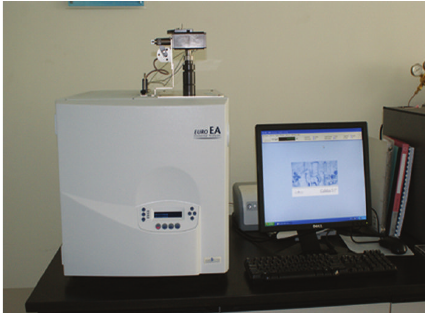
Figure 2: A ThermoQuest elemental analyzer.